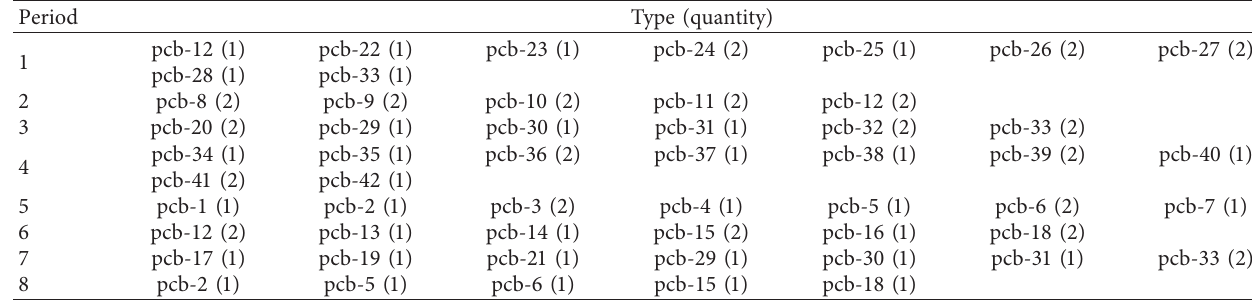
Table 3: PC component arrival